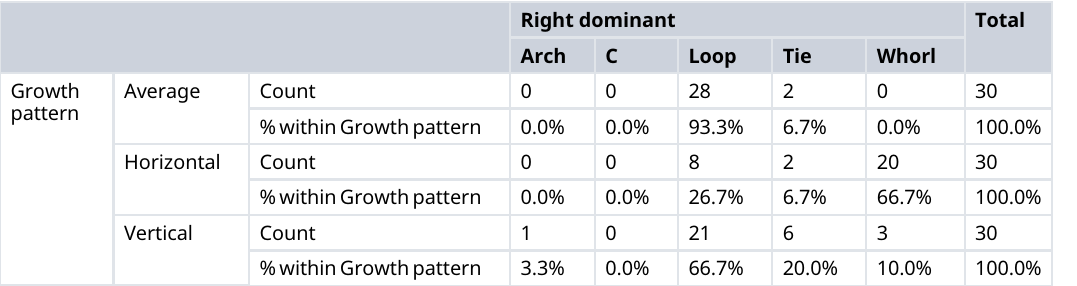
Table 5. Overall comparison for between groups (Right hand).